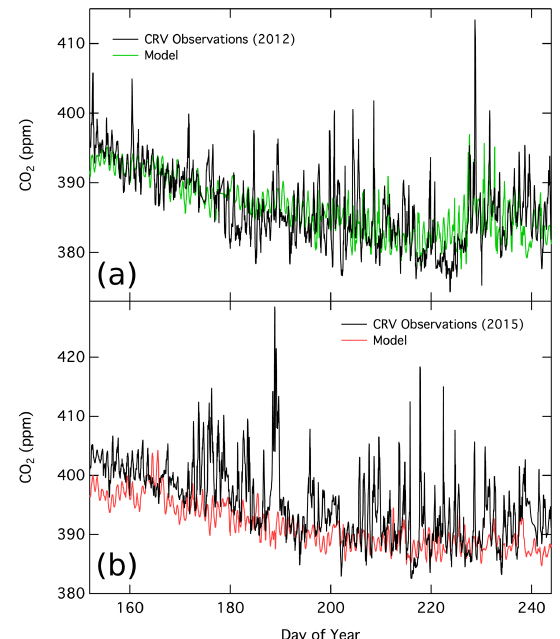
Figure 2. (a) Observations of CO 2 mole fraction at the CRV tower in 2012 (black line) along with model estimates of the CO 2 back- ground (green line) at CRV using the approach described in the main text. Very few fires occurred during 2012, and as a conse- quence most of the CO 2 variability in the observations and in the model is associated with terrestrial net ecosystem exchange. (b) In 2015 wildfires in interior Alaska contributed significantly to CO 2 variability at the CRV tower, causing positive anomalies in the ob- servations shown in black, particularly between days 170 and 190. The modeled background for 2015 is shown in red. The CO 2 mole fraction observations and model estimates have a 1h temporal res-